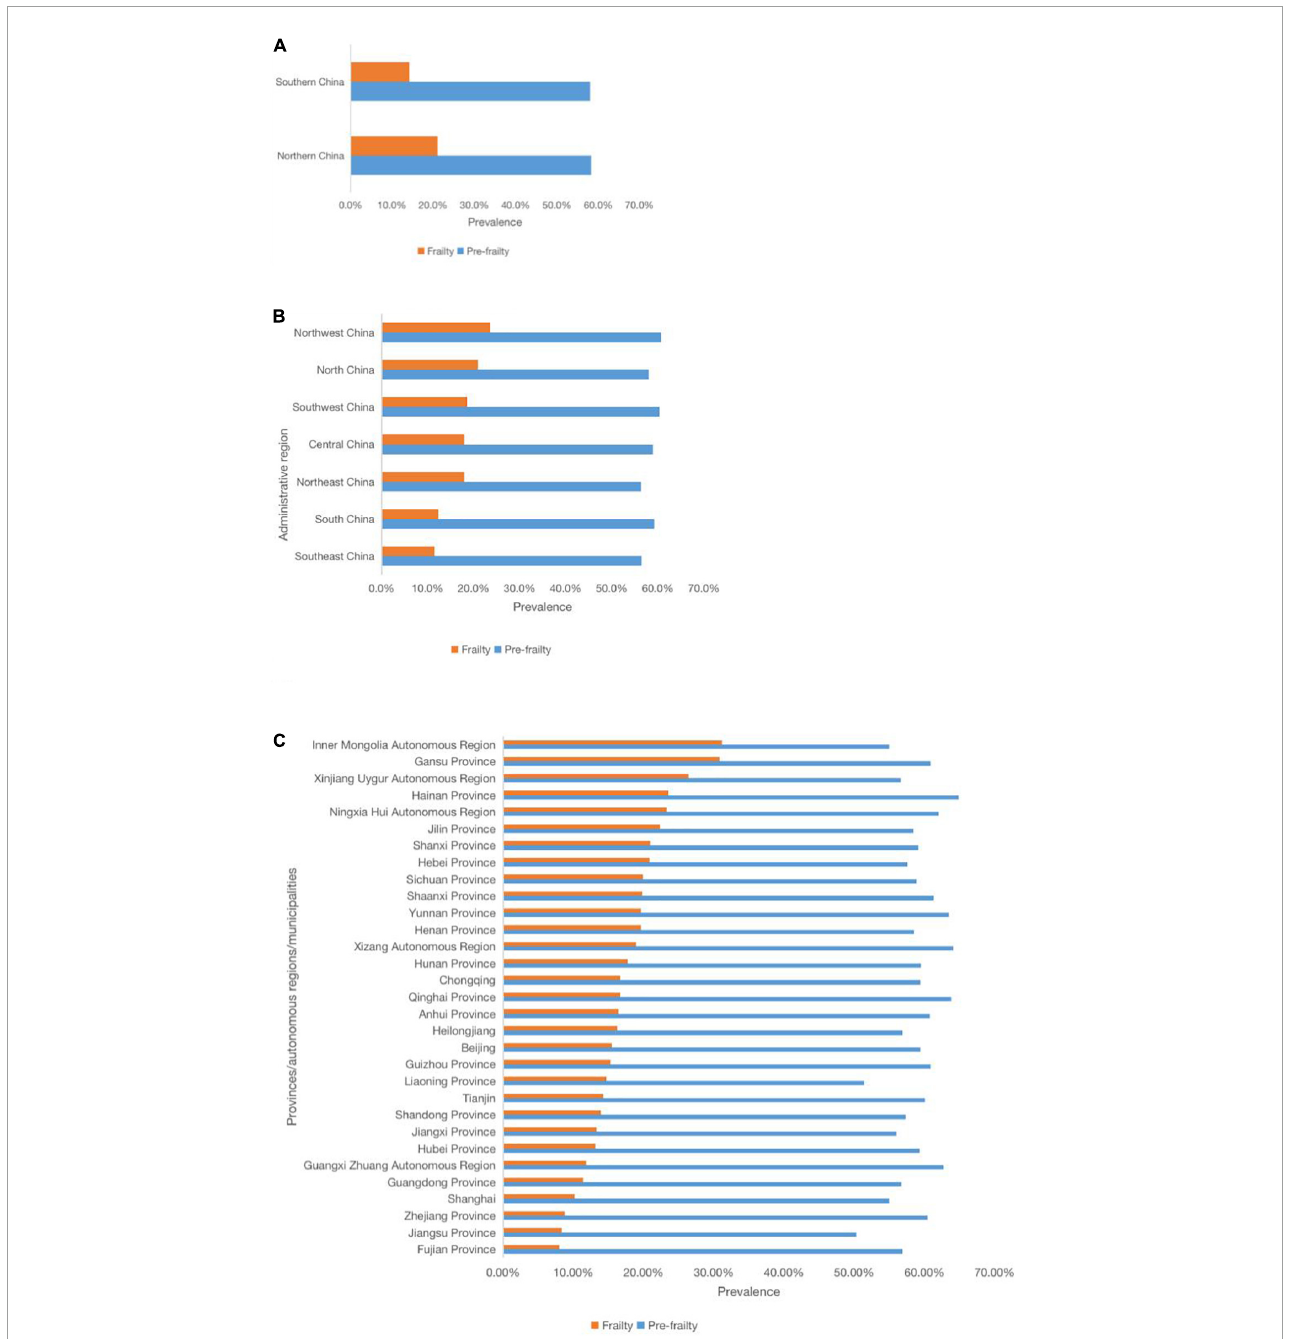
FIGURE3 Prevalence of frailty and pre-frailty in older adults with hypertension in different regions of mainland China. (A) Prevalence of frailty and pre-frailty in older adults with hypertension in different provinces, municipalities, and autonomous regions. (B) Prevalence of frailty and pre-frailty in older adults with hypertension in different administrative regions. (C) Prevalence of frailty and pre-frailty in older adults with hypertension in different Northern and Southern